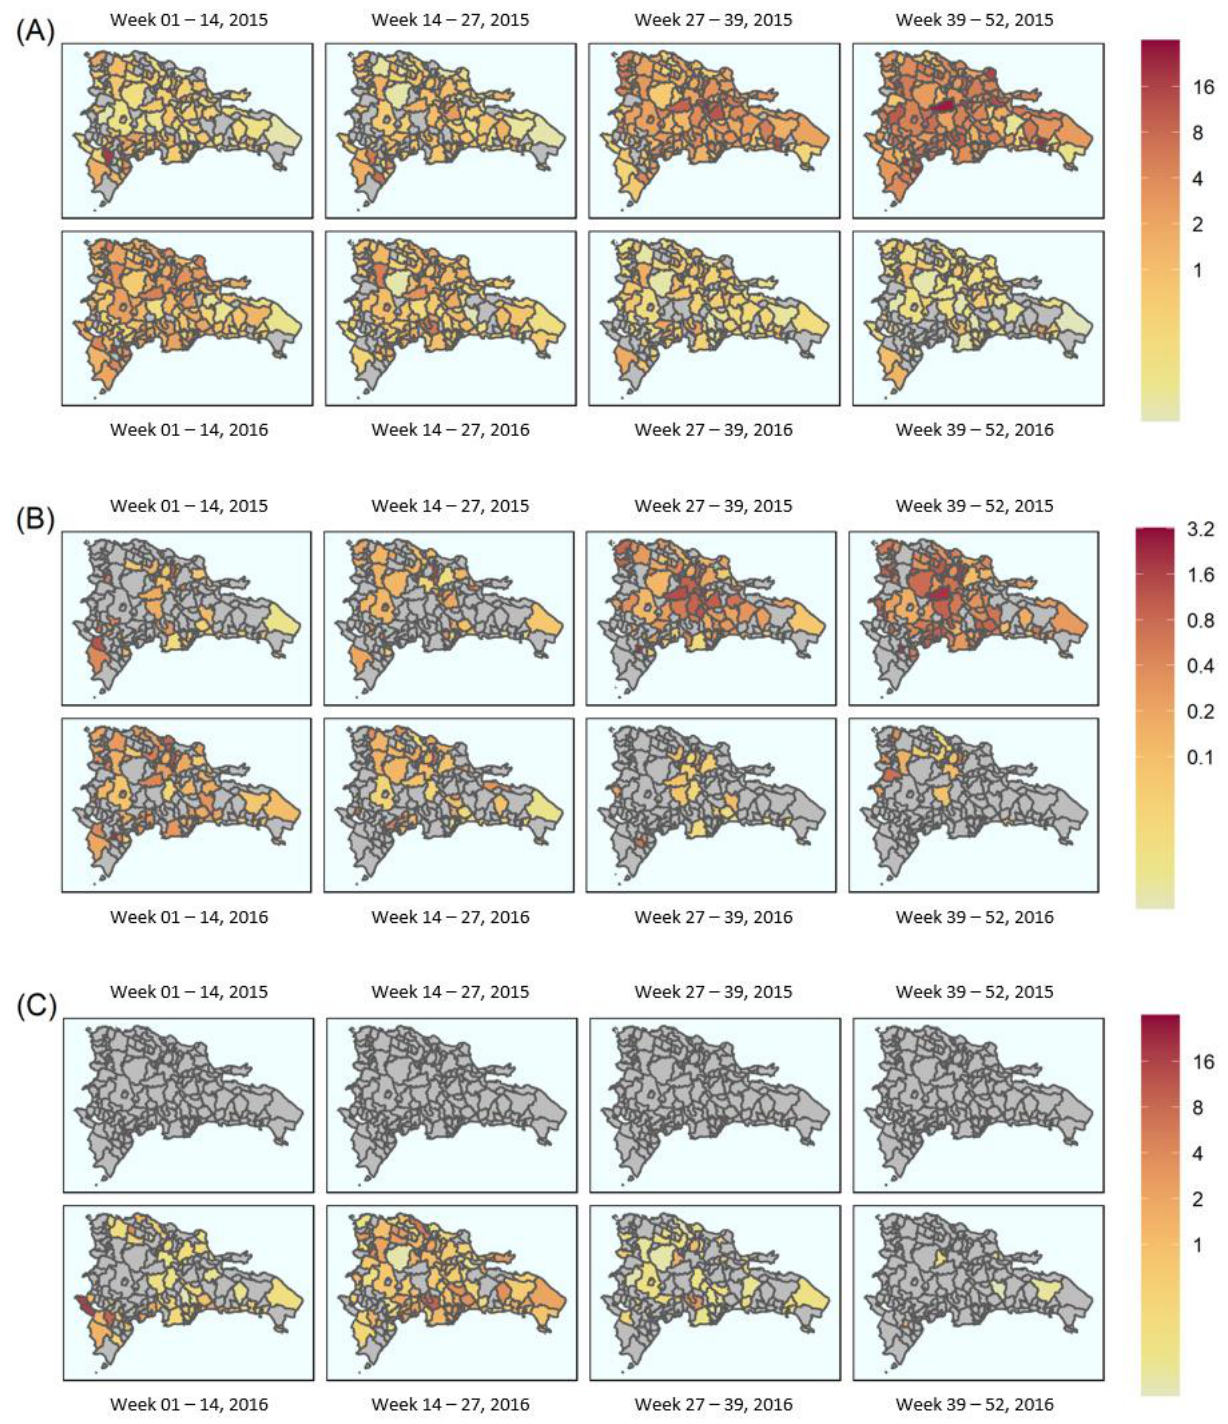
Figure 3. Breakdown of the aggregated spatial distribution of cases over the 2014 – 2016 epidemic period by epidemiological week at the municipal level: ( A ) dengue cases over 2015 (top row) and 2016 (bottom row); ( B ) complicated dengue cases over 2015 (top row) and 2016 (bottom row); ( C ) Zika cases over 2015 (top row) and 2016 (bottom row). Continuous colour scale from white (lowest) through to red (highest) for all images. Scales vary as shown. Grey areas indicate absence of data. All counts per 10,000 population. Dates are over epidemiological weeks 1 – 52 for each year, where the year is split into weeks 1 – 14, 14 – 27, 27 – 39 and 39 – 52.